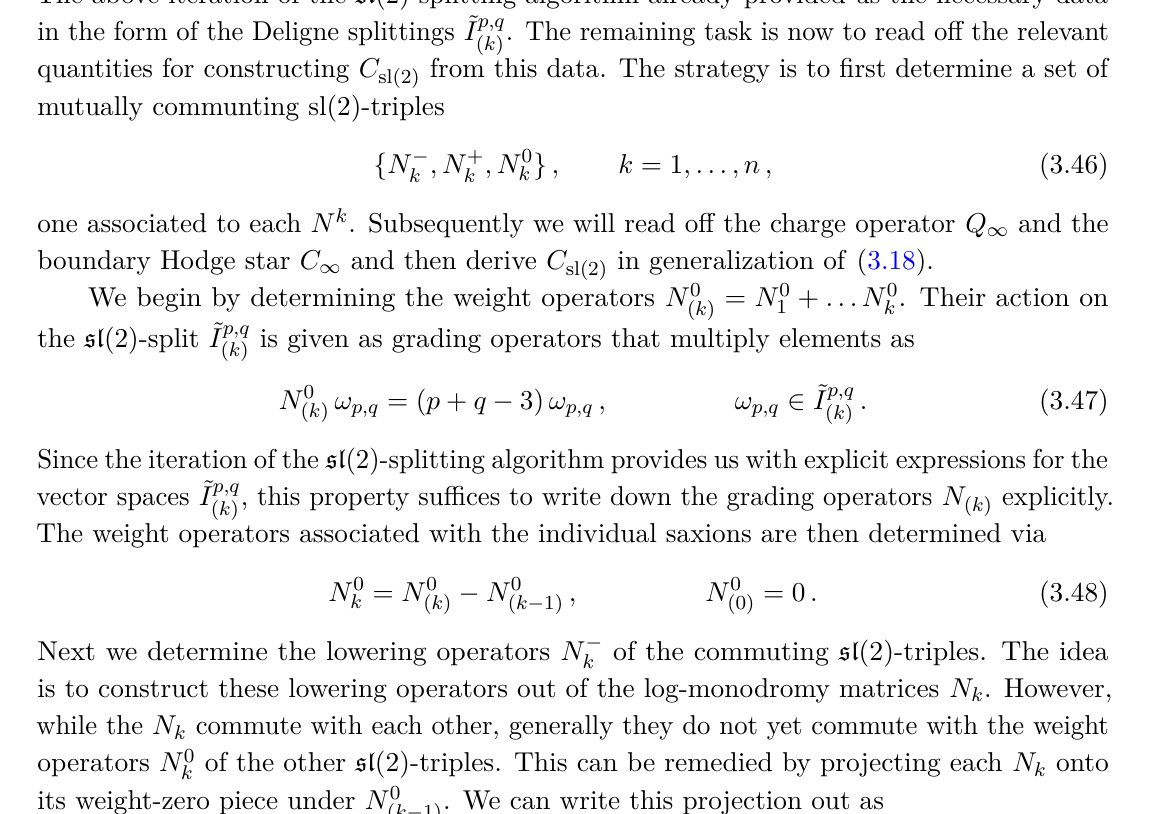
Algorithm III: constructing the sl(2) triples and sl(2)-approximated Hodge